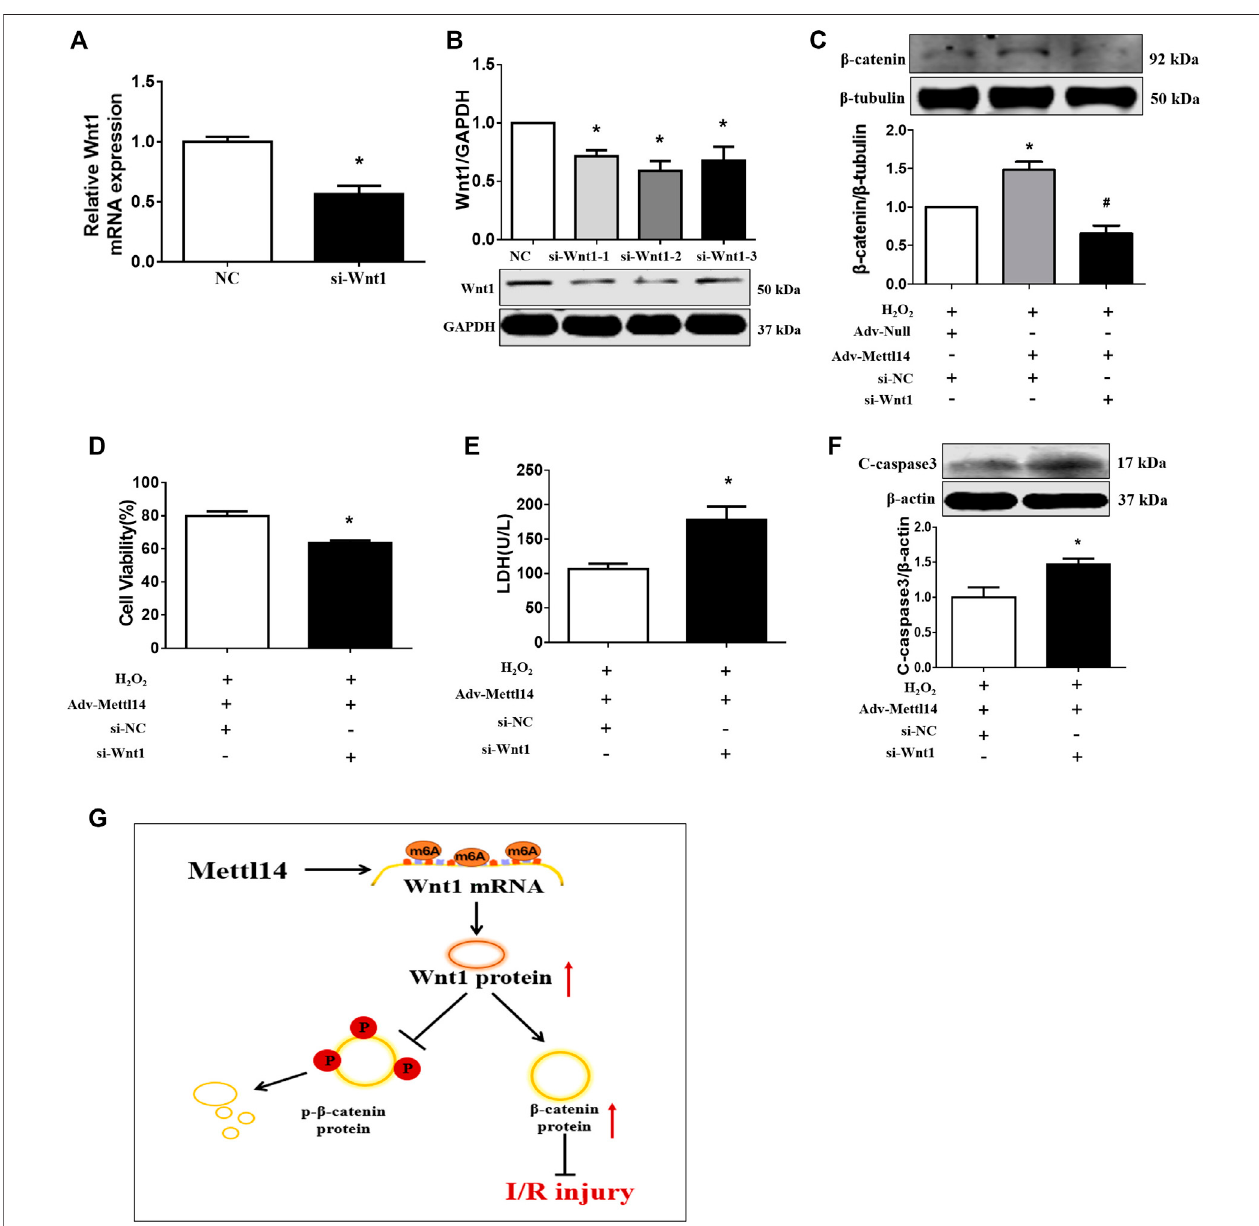
FIGURE 7 | Knockdown of Wnt1 abolished Mettl14-mediated cardioprotection in vitro . (A , B) Cardiomyocytes were infected by si-RNA. The expression of Wnt1 was analyzed by (A) qRT-PCR and (B) Western blotting. n (cid:2) 3 from three independent cultures. * p < 0.05 versus NC. (C) Cardiomyocytes were co-transfected with the Mettl14 vector or empty vector and si-Wnt1. The β -catenin protein level was analyzed by Western blotting. n (cid:2) 3 from three independent cultures. * p < 0.05 versus H 2 O 2 +Adv-Null. # p < 0.05 versus H 2 O 2 +Adv-Mettl14. (D) Cell viability was detected with CCK8. n (cid:2) 6 from three independent cultures. * p < 0.05 versus H 2 O 2 +Adv-Mettl14. (E) TheculturemediumlevelofLDH. n (cid:2) 8fromthreeindependentcultures.* p < 0.05versusH 2 O 2 +Adv-Mettl14. (F) Thecleavedcaspase-3protein level was analyzed by Western blotting. n (cid:2) 5 from three independent cultures. * p < 0.05 versus H 2 O 2 +Adv-Mettl14. Data are represented as mean ± SEM. (G) Schematic showing the proposed mechanism for the effects of Mettl14 on cardiac ischemia – reperfusion injury. During cardiac ischemia – reperfusion injury, Mettl14 expression is increased, which improves Wnt1 mRNA m6A modi fi cation. Therefore, Wnt1 expression is upregulated, and the Wnt/ β -catenin pathway is activated. The β -catenin phosphorylation is inhibited, and β -catenin is accumulated. To sum up, it has a protective effect on the heart damaged by ischemia – reperfusion.